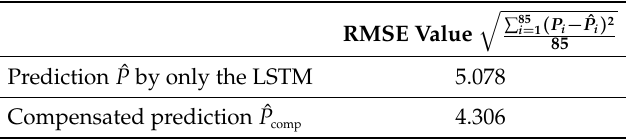
Figure 13. Compensated load forecast ˆ P Table 2. Root Mean Square Error (RMSE) value for test